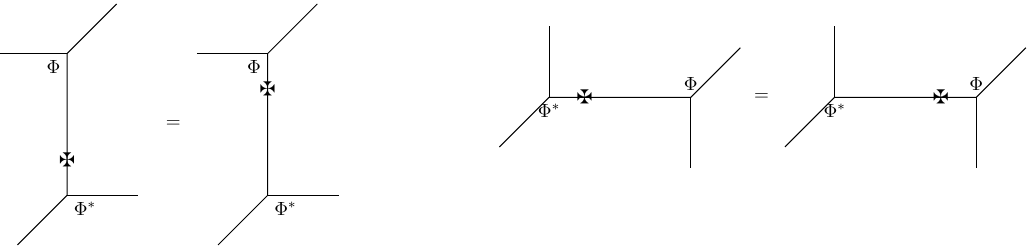
Figure 7 . Commutation relations in the vertical and horizontal channels (respectively) for the insertion of DIM operators, here denoted by the symbol z .